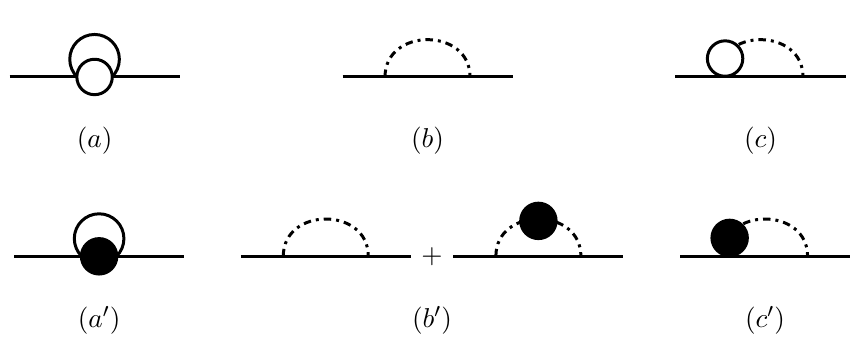
Figure 9 . Diagrams that correct the two-point function ˆ G up to 4 vertexes. The second line includes bubble resummations.